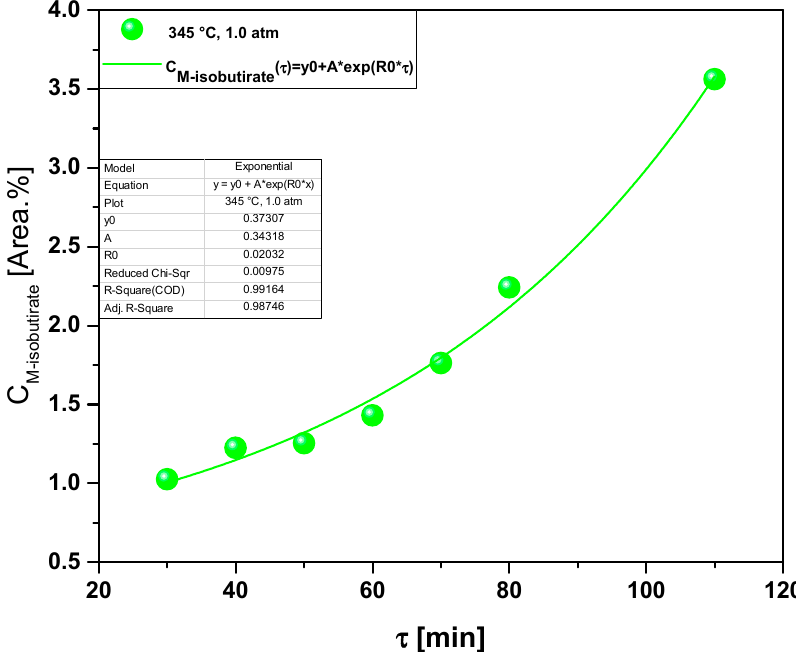
Figure 11. Concentration of methyl iso-butyrate, a side reaction product, in the liquid phase by de- polymerization of PMMA based dental resins fragments/residues at 345 °C, atmospheric pressure, within the time interval of 30 to 110 min.